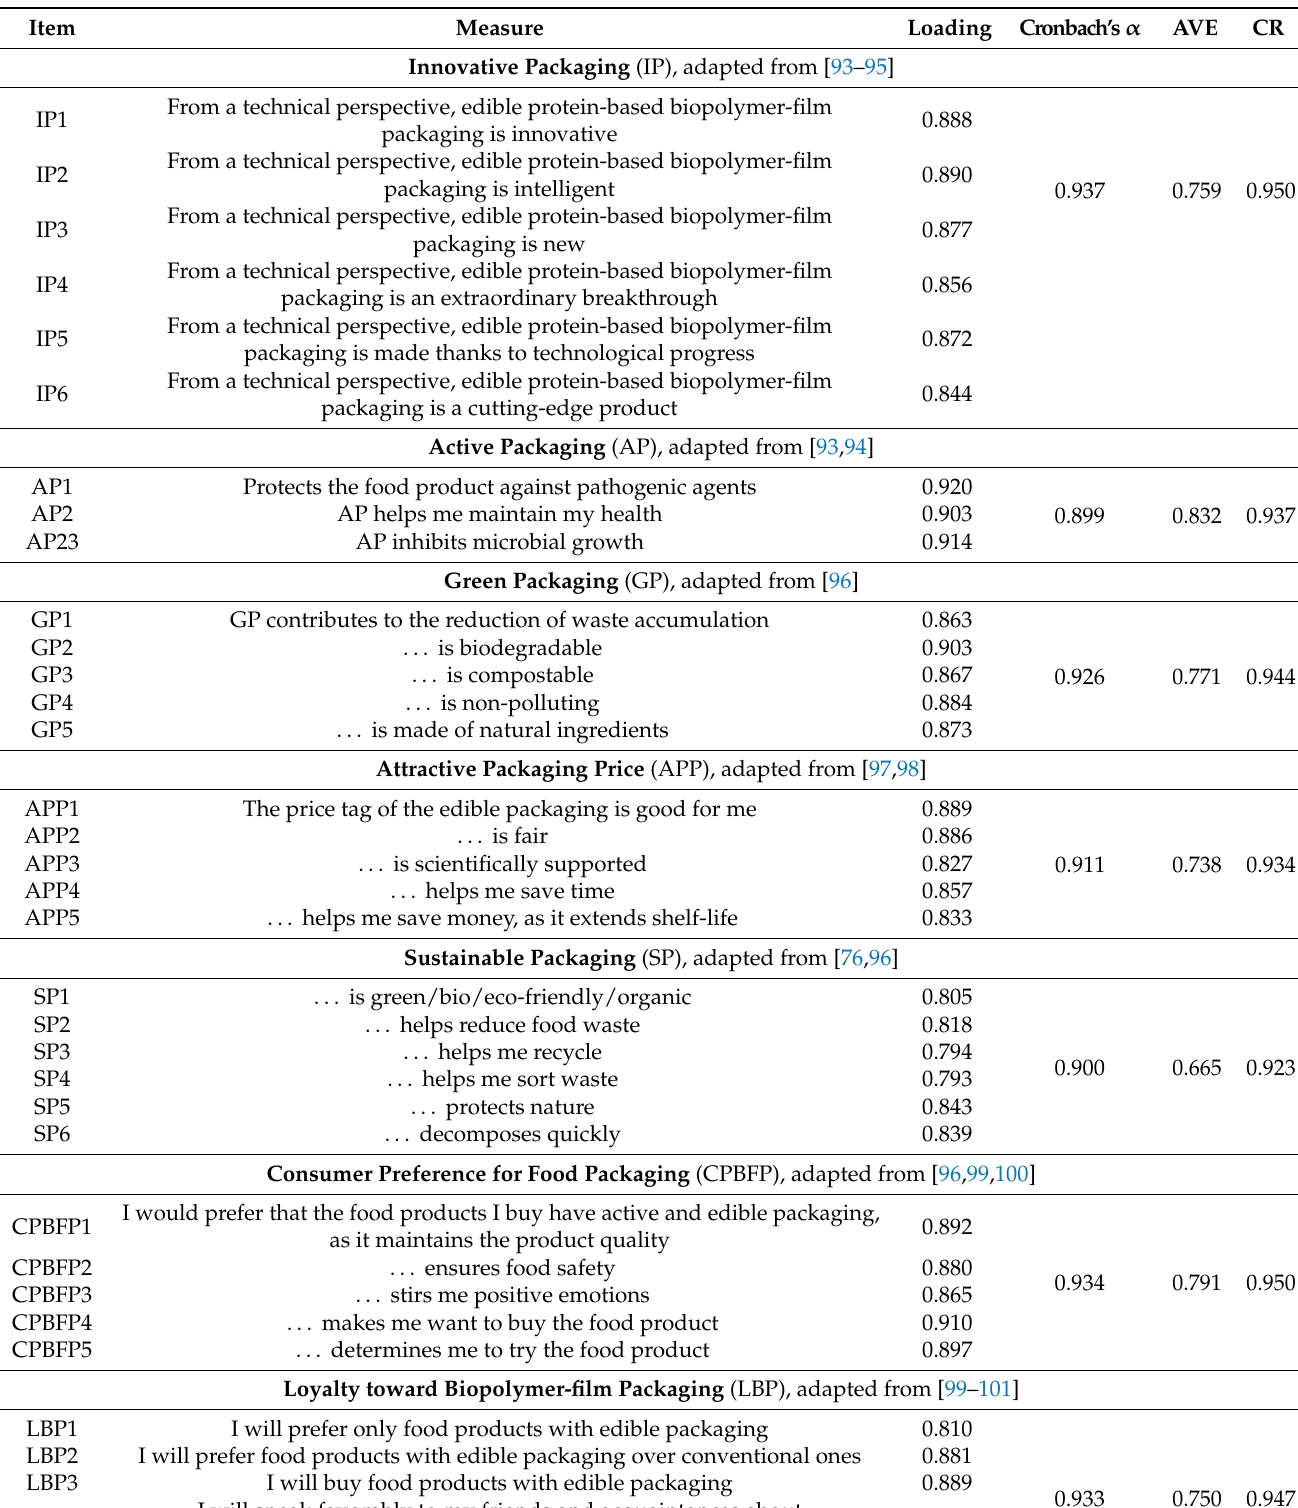
Table 1. Constructs and